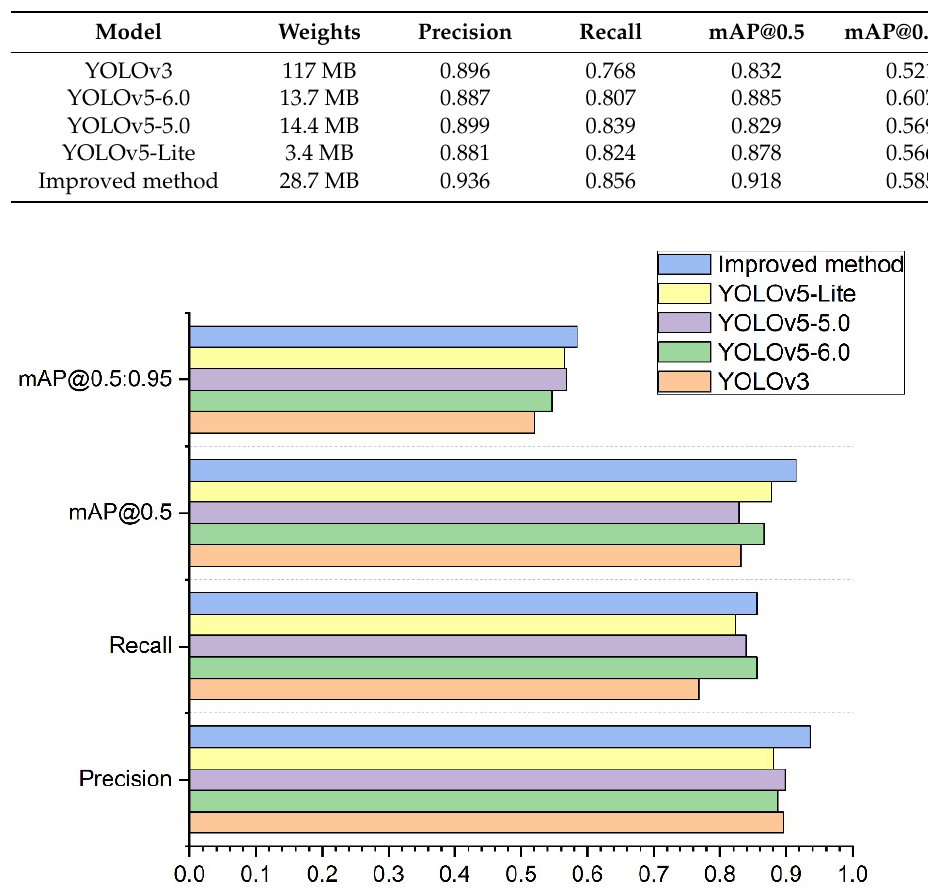
Table 7. Comparison of test results of YOLOv3, YOLOv5-6.0, YOLOv5-5.0, YOLOv5-Lite, and the improved method using the productionlineData homemade dataset.